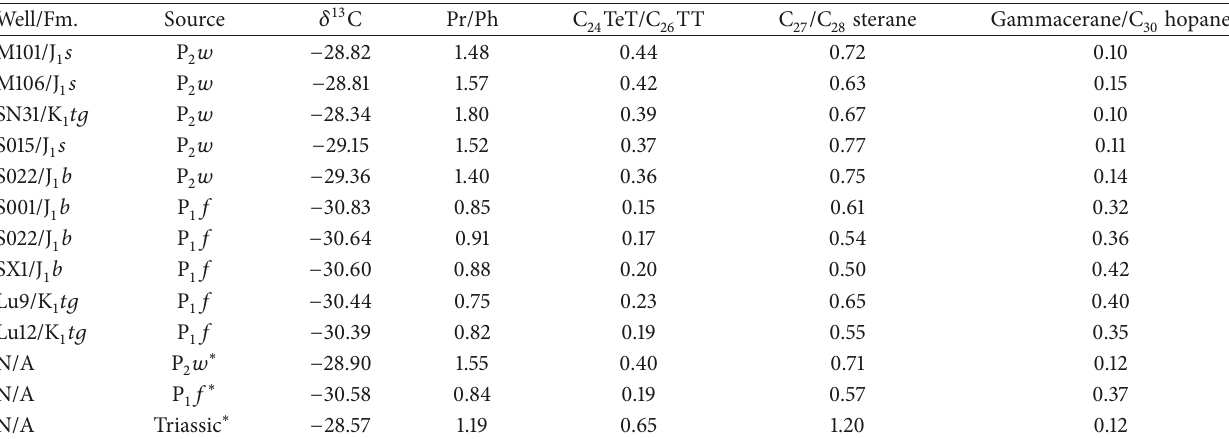
Table 6: Representative parameters and their values used in calculation of oil-source contribution.